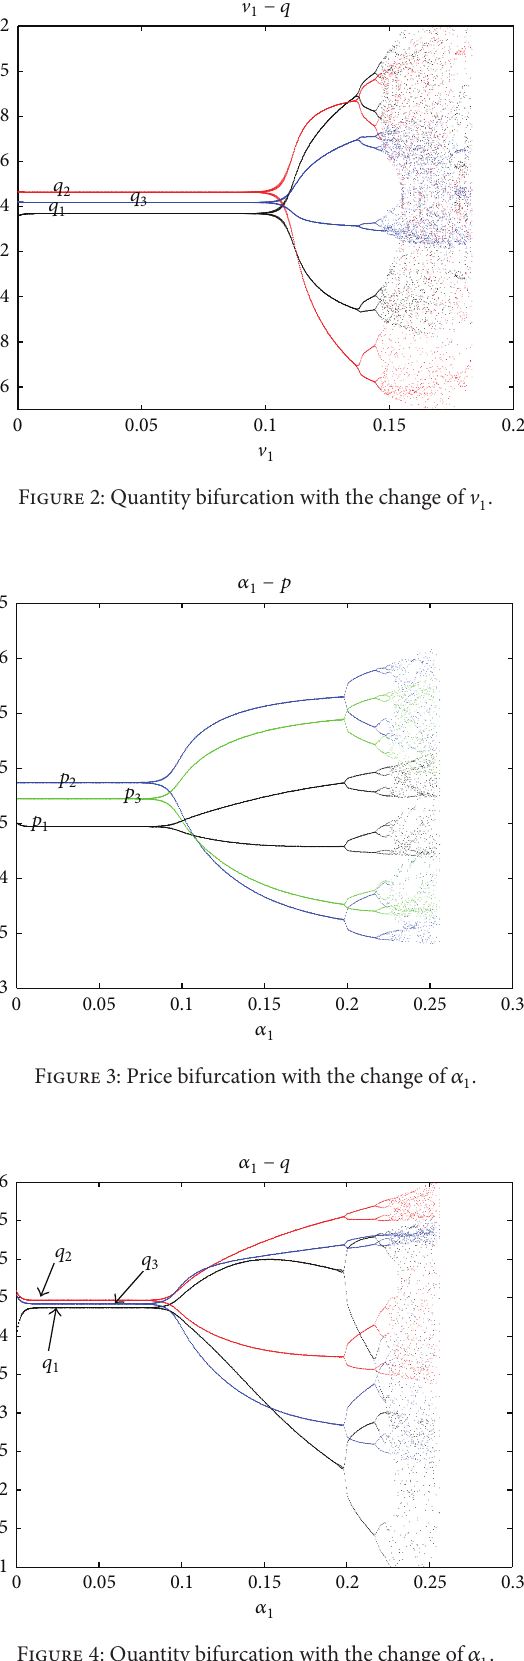
Figure 4: Quantity bifurcation with the change of 𝛼 1 .